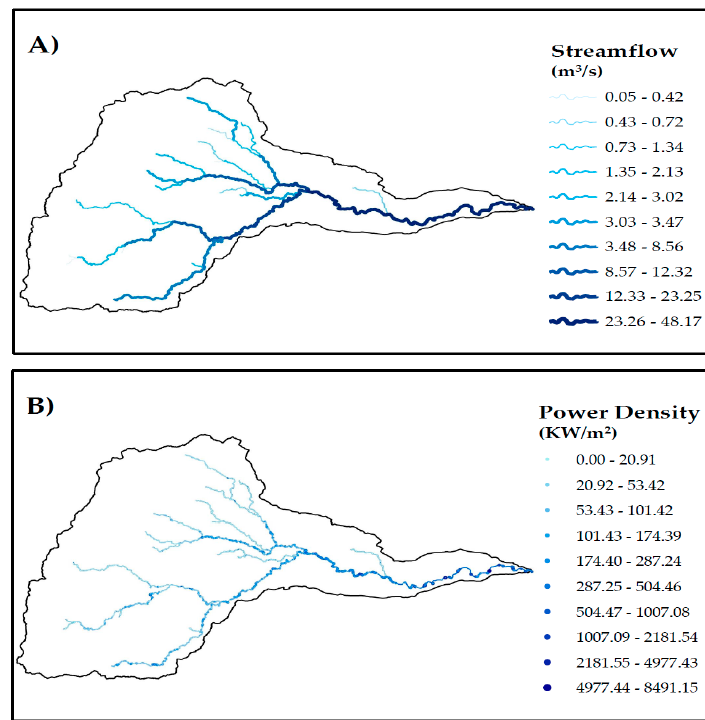
Figure 5. ( A ) Spatial distribution of the simulated flow average (1990–2009) and ( B ) spatial distribution of the power density (1990–2009).